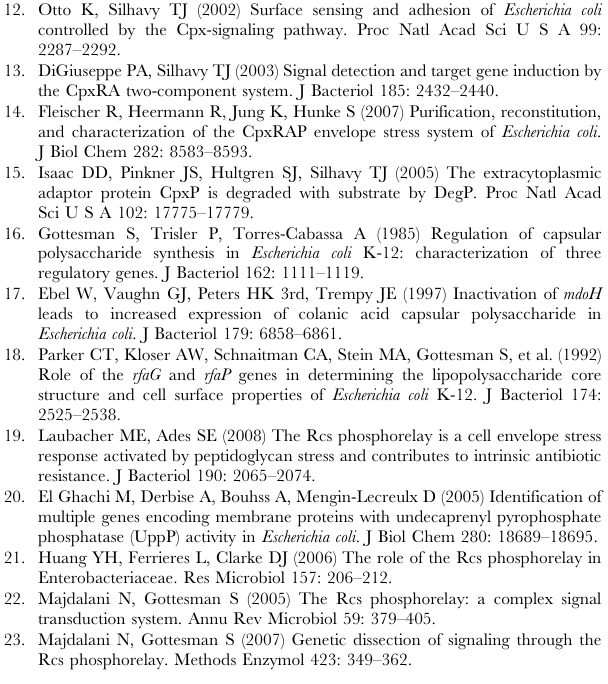
Table S2 Primers used for this